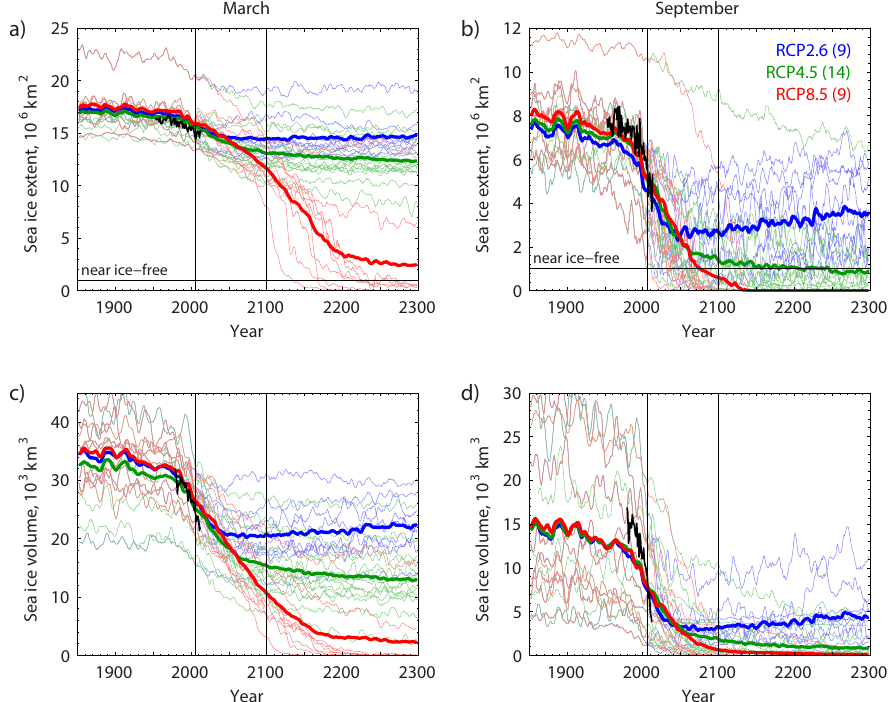
Figure 2. The multi-model mean time series of Arctic sea ice extent, 10 6 km 2 , (top) and sea ice volume, 10 3 km 3 , (bottom) for March (left) and September (right) under RCP2.6 (blue), RCP4.5 (green), and RCP8.5 (red) from 1850 to 2300. Individual ensemble members are shown as lighter lines (5-year running mean). One ensemble member is used from each model. The time series in the historical period (through 2005) differ slightly because of the different models available for each scenario. The number of models used is given in parentheses next to the RCP. For comparison, observed sea ice extent (black) is from Meier et al. (2012). This data set combines observations from passive microwave sensors and the HadISST time series. Reanalysis of sea ice volume (black) is from the PIOMAS model (Schweiger et al., 2011), and is the “unadjusted” time